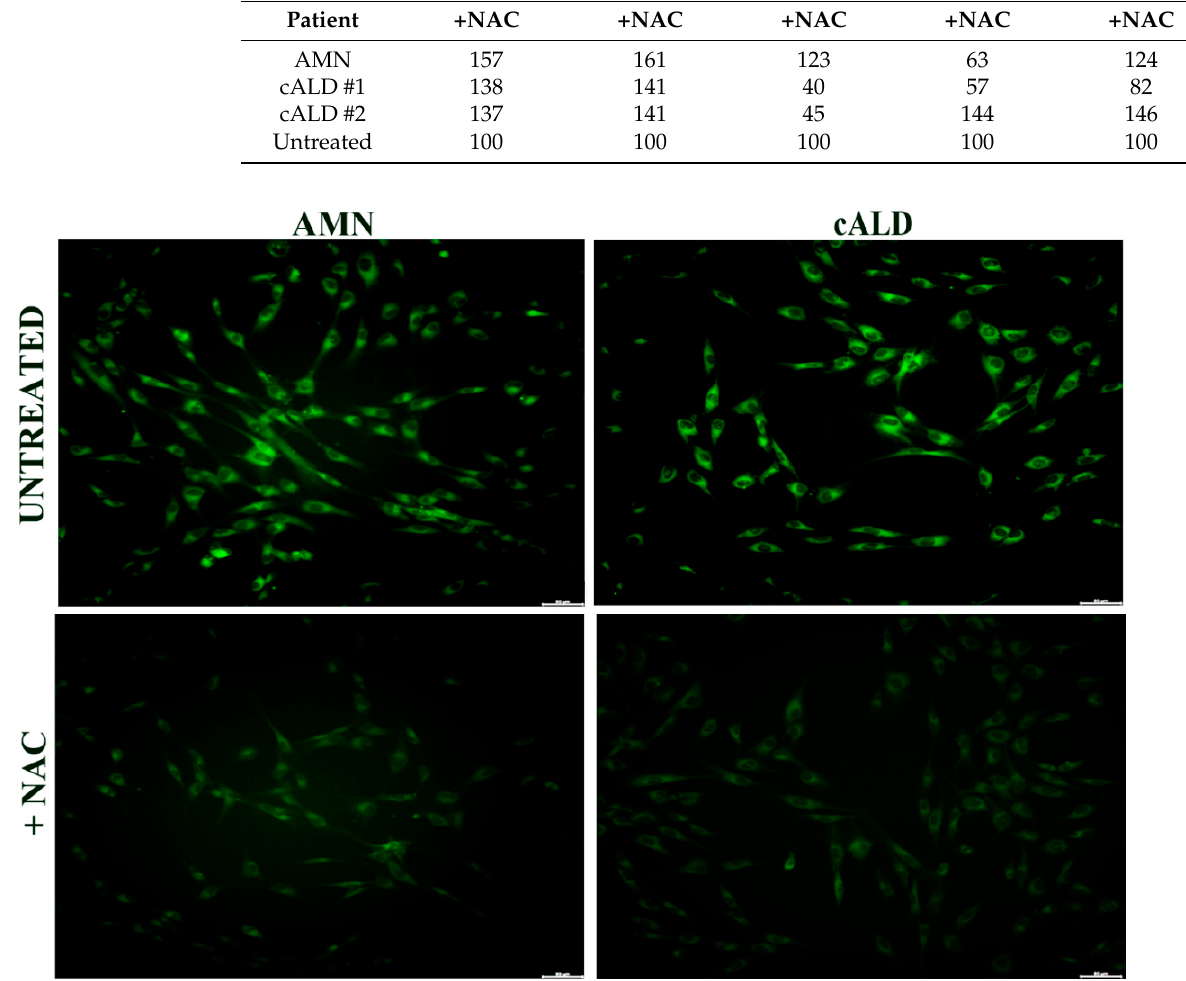
Figure 5. Representative images of Lipid peroxides staining (green), detected by using the fluorescent lipophilic Bodipy-C11 sensor, of X-ALD fibroblasts after 24 h treatments with NAC (100 µ M, scale bar = 100 μ m).